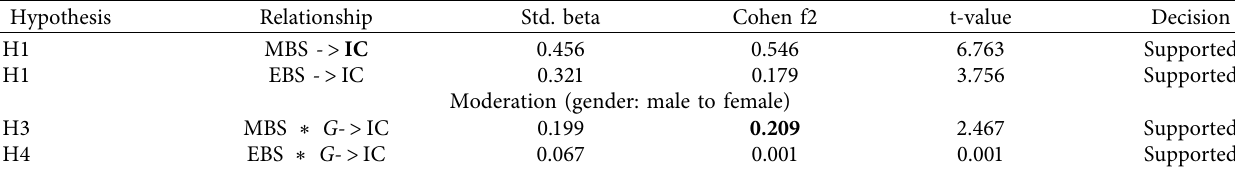
Table 5: Hypotheses testing results.